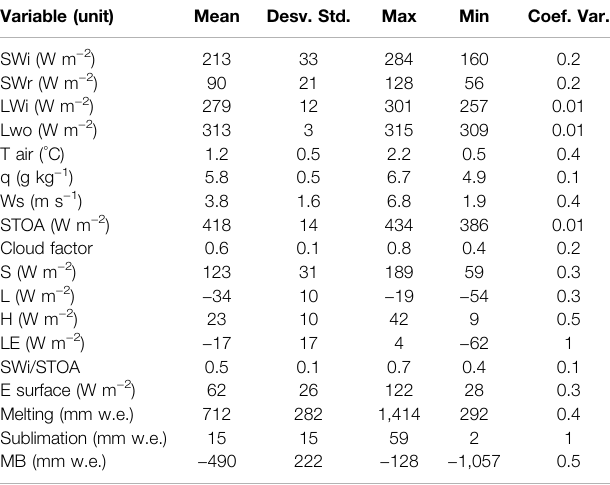
TABLE 4| Summary ofMean monthly values ofmeteorologicaland SEB variables at SAMA-1 location during SP. Des. Std. and Coef. Var. refer to standard deviation and coef fi cient of variation, respectively. Variable